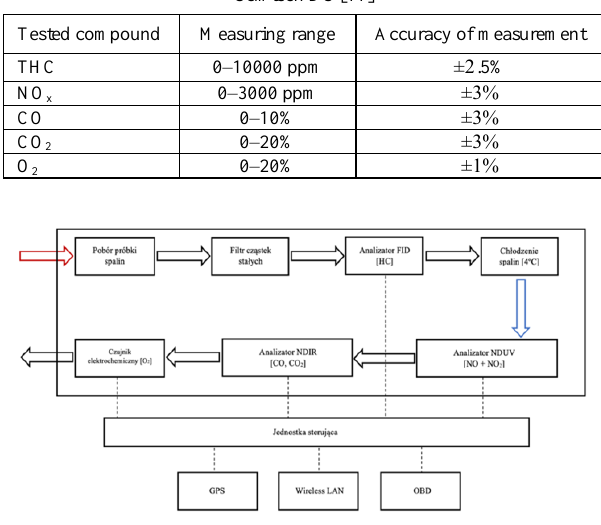
Fig. 2. Scheme of the operation of the SEMTECH DS analyzer [12]